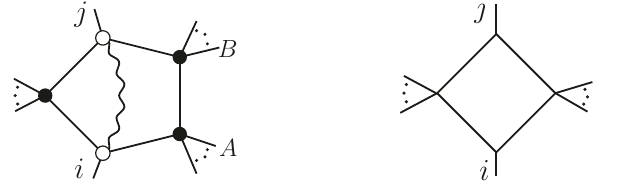
(5.4), on the left. The one-loop box in the ij (5.6), on the ij